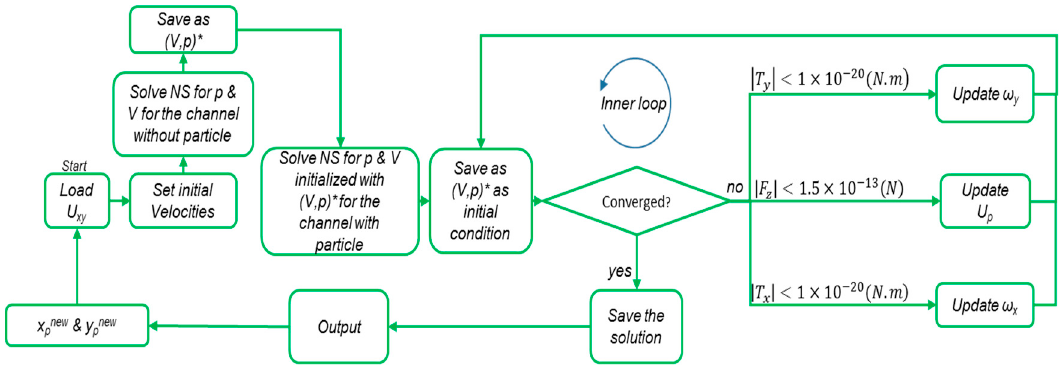
Figure 2. The modified algorithm for calculating the lift force exerted on particles in the entrance channels. The initial values of the U p and ω x , ω y are set from the velocity and angular velocity by solving the Navier–Stokes equations ( NS ) for laminar incompressible flow in a channel without particles. With these initial conditions, the NS will be solved in a channel with particles in the x p and y p positions. In the inner loop, after each iteration, the values of ( V , p ) are used as the initial conditions for the next iteration.